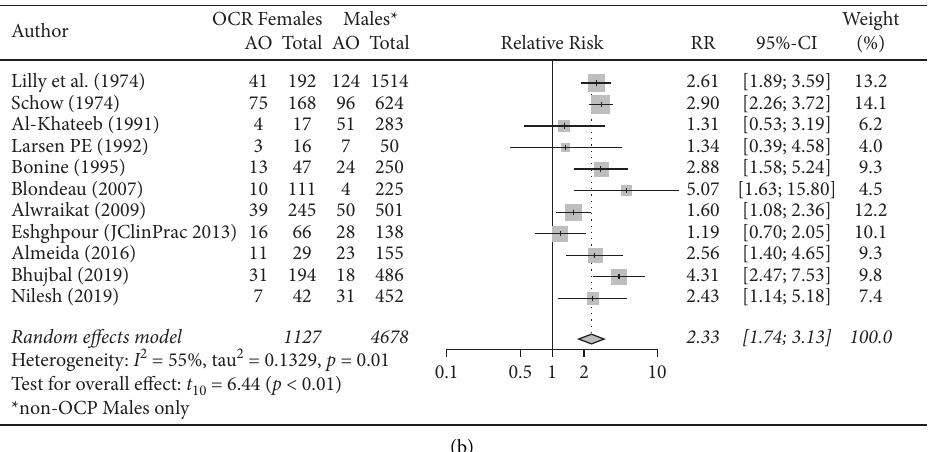
Figure 3: AO among OCP users analysed by